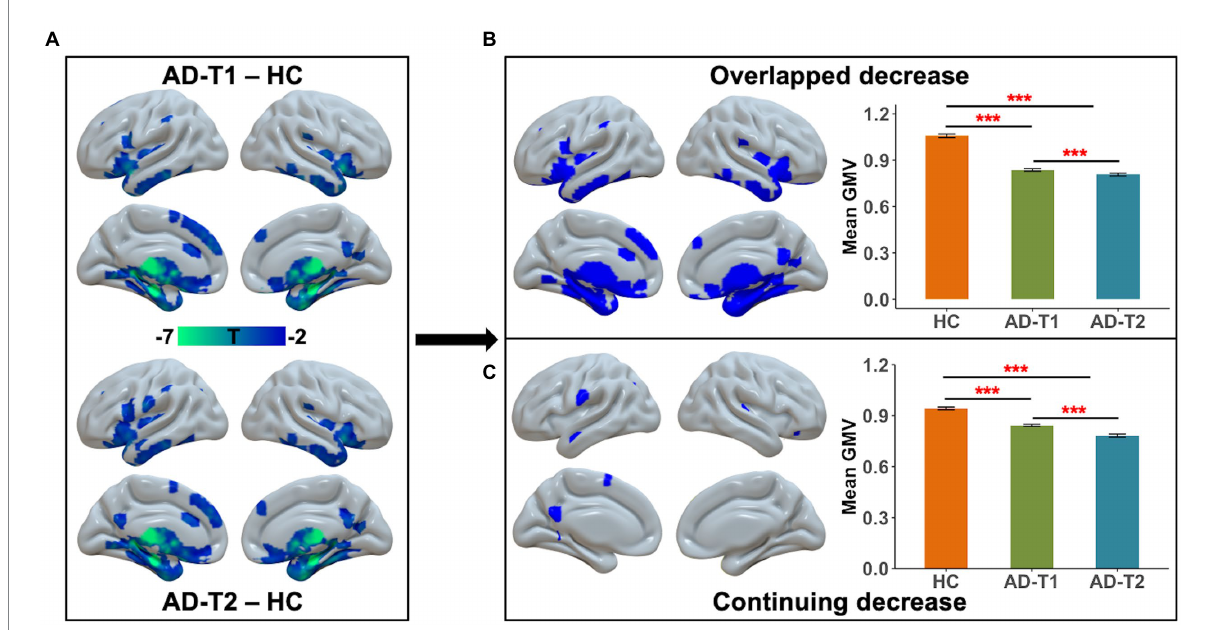
FIGURE 2 Brain areas showing substantial atrophy in grey matter volume in AD patients. (A) There was reduced grey matter volume in inferior frontal gyrus, prefrontal cortex, lateral temporal gyrus, posterior cingulate cortex, insula, hippocampus, caudate, and thalamus in both AD-T1 and AD-T2 as compared to HC. (B) The areas that showed grey matter atrophy in both AD-T1 vs. HC and AD-T2 vs. HC were identified as overlapped decrease areas, and the mean grey matter volume values within these areas are significantly different between HC and AD-T1, between HC and AD-T2, and between AD-T1 and AD-T2. (C) The regions that showed differences between AD-T2 vs. HC and AD-T1 vs. HC were identified as continuing decrease areas, and the mean grey matter volume values within these regions are significantly different between HC and AD-T1, between HC and AD-T2, and between AD-T1 and AD-T2. All brain maps were corrected with the FDR method ( p < 0.05, cluster size >30 voxels). Error bars represent the standard error of the mean. *** p <